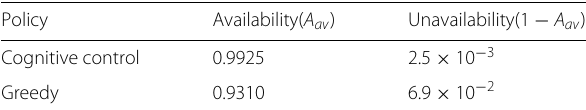
Table 4 The availability of train-ground communications under different policies Policy Availability( A av ) Unavailability(1 − A av ) Cognitive control 0.9925 2.5 × 10 − 3 Greedy 0.9310 6.9 × 10 − 2